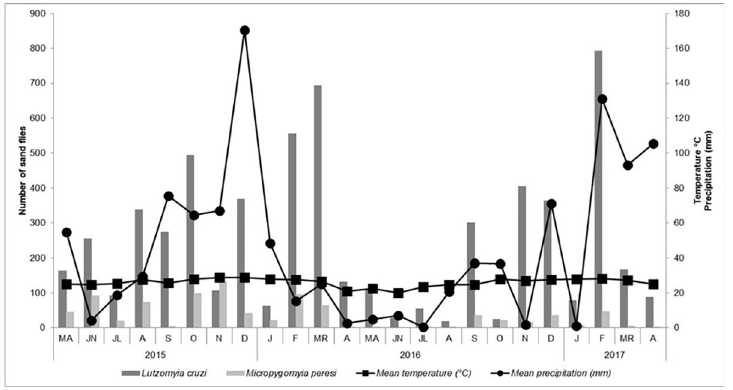
Fig 6. Temperature, precipitation, and seasonal distribution of Lutzomyia cruzi and Micropygomyia peresi , Corumba´, Mato Grosso do Sul, Brazil. May 2015 to April